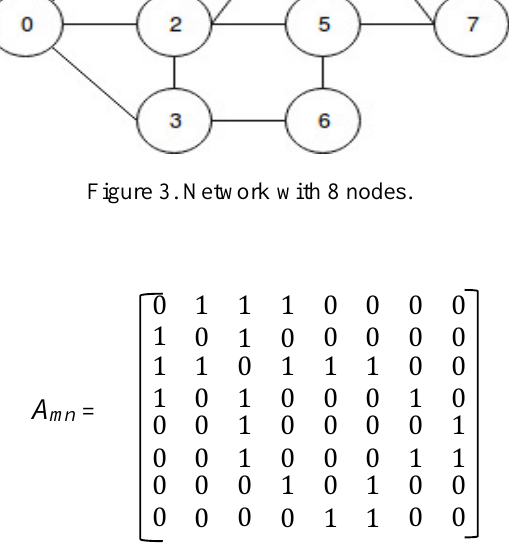
Figure 4. Adjacency